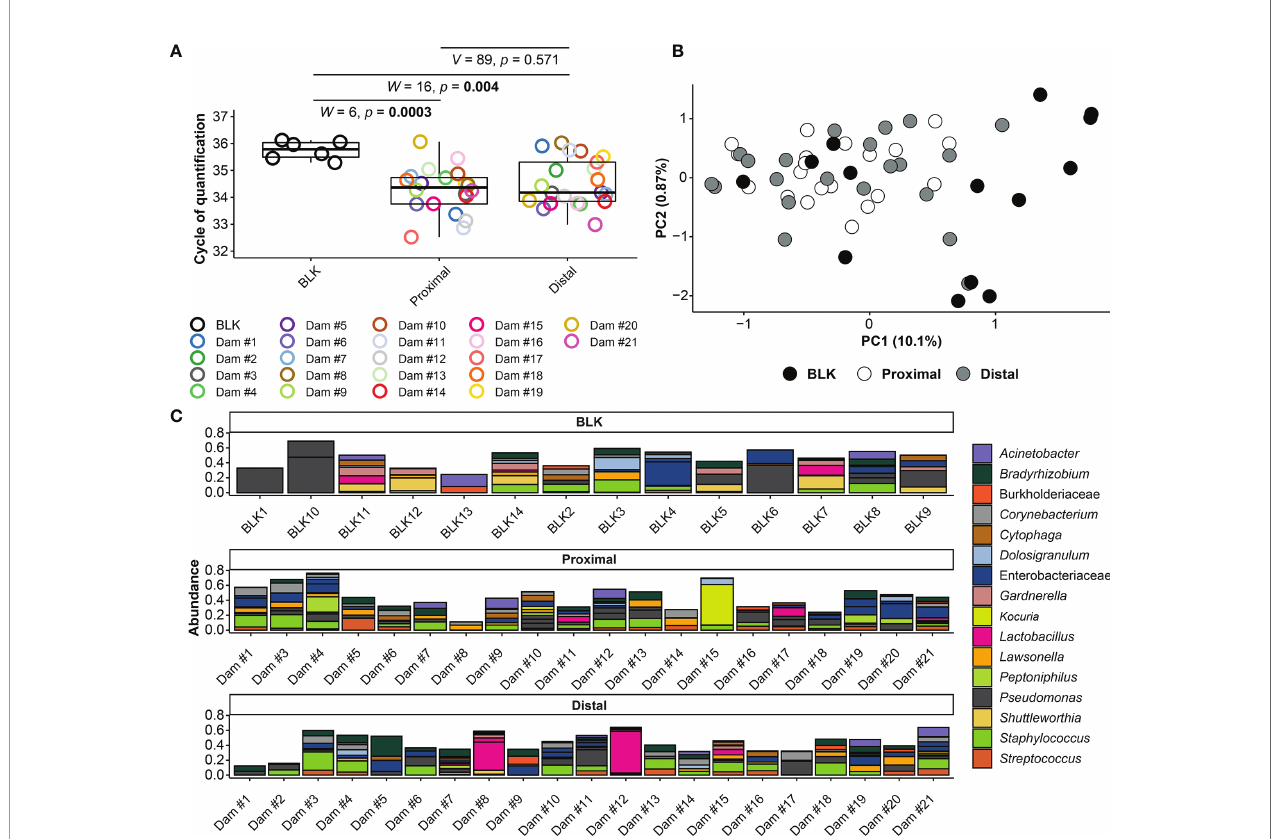
FIGURE 2 | 16S rRNA gene qPCR and sequencing results for amniotic fl uid and blank control samples. (A) Cycle of Quanti fi cation (Cq) values from qPCR of proximal and distal amniotic fl uid and blank control (BLK) samples. (B) Principal coordinate analysis (PCoA) illustrating variation in 16S rRNA gene pro fi les among proximal and distal amniotic fl uid and blank control samples. Similarities in the 16S rRNA gene pro fi les were characterized using the Bray-Curtis similarity index. (C) Taxonomic classi fi cations of the 20 amplicon sequence variants (ASVs) with highest relative abundance across all proximal and distal amniotic fl uid and blank control samples. Bars of identical color within the same sample indicate multiple ASVs with the same bacterial taxonomic classi fi cation. The DNA extract of the proximal amniotic fl uid sample from Dam #2 did not yield a 16S rRNA gene sequence